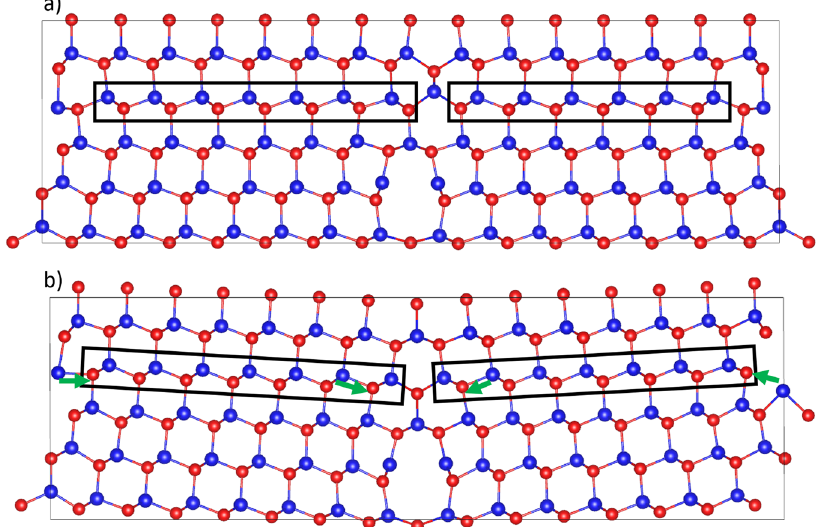
Fig. 5 Clean Σ 3 grain boundary structure. a Stacking fault structure where the stacking fault layer between two grain boundaries is indicated by the rectangle. b The same structure with the stacking fault layer removed. The green arrows indicate the Te atom displacements required to transform to the structure shown in ( a ). Cd: Blue, Te: Red.